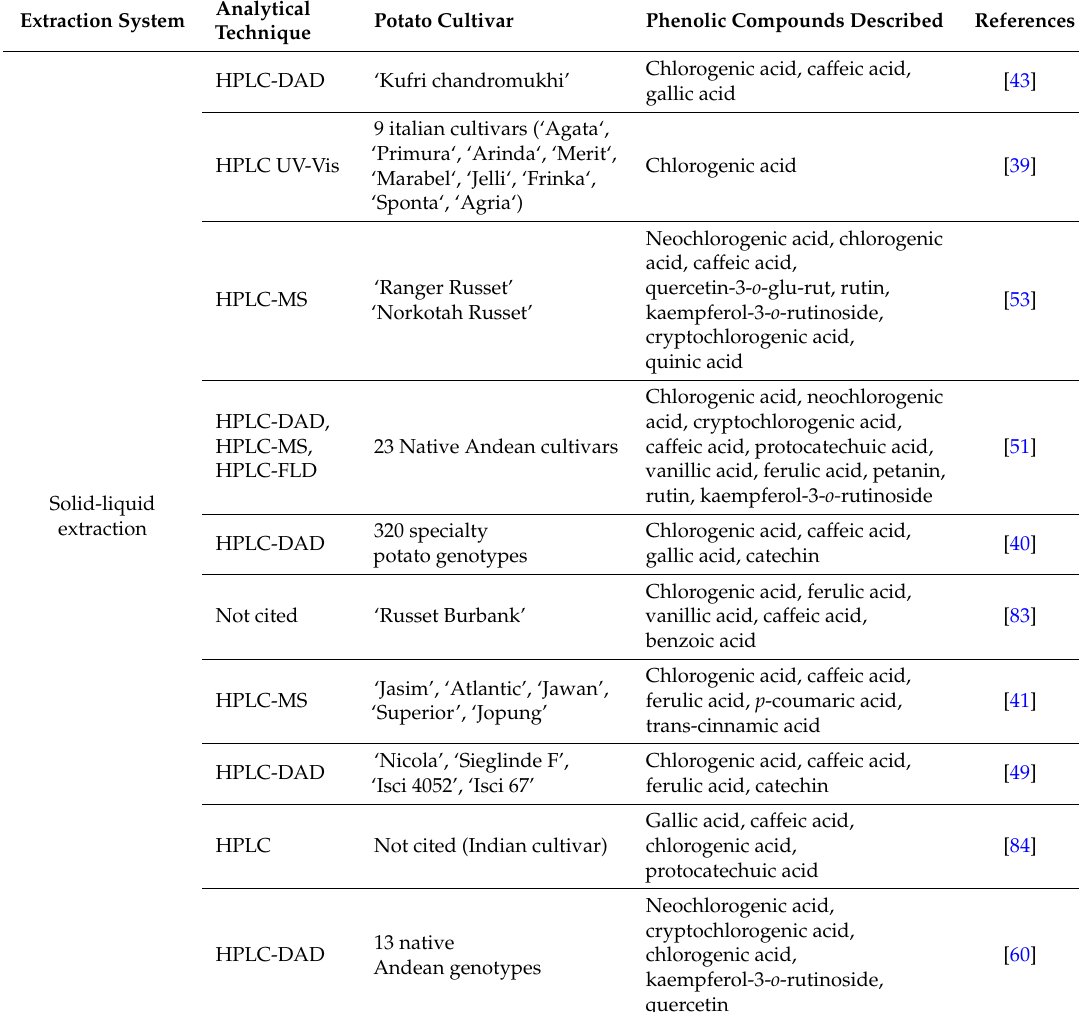
Table 2. Overview of the extraction systems and analytical methods used for phenolic compounds determination in